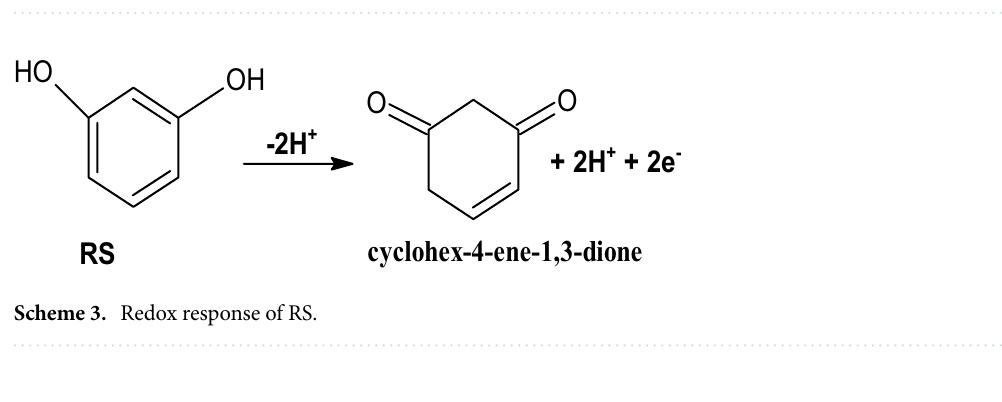
Figure 8. CVs curve for 10 µM RS in 0.2 M PBS (pH 7.4) at BCPE (scattered streak) and poly(CBBG)/MCPE (hard streak) with scan rate of 0.05 Vs −1 .